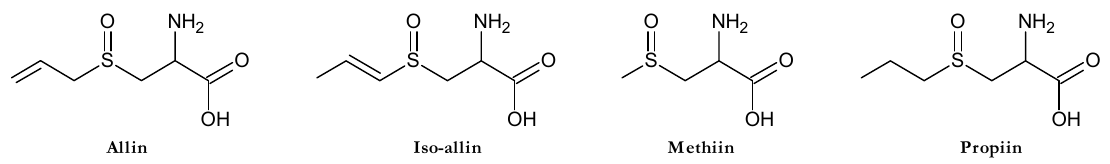
ff erent Allium